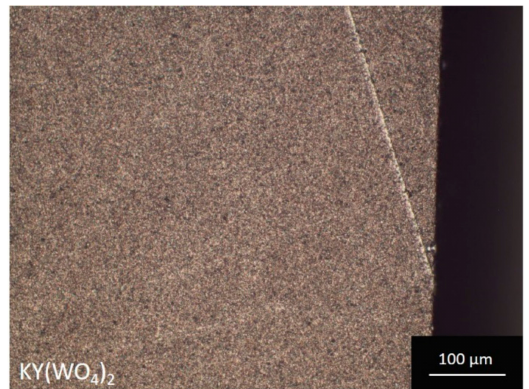
Figure 11. Microscope image of a chipped edge on a 56 µ m thin KY(WO 4 ) 2 sample that caused a scratch on the sample